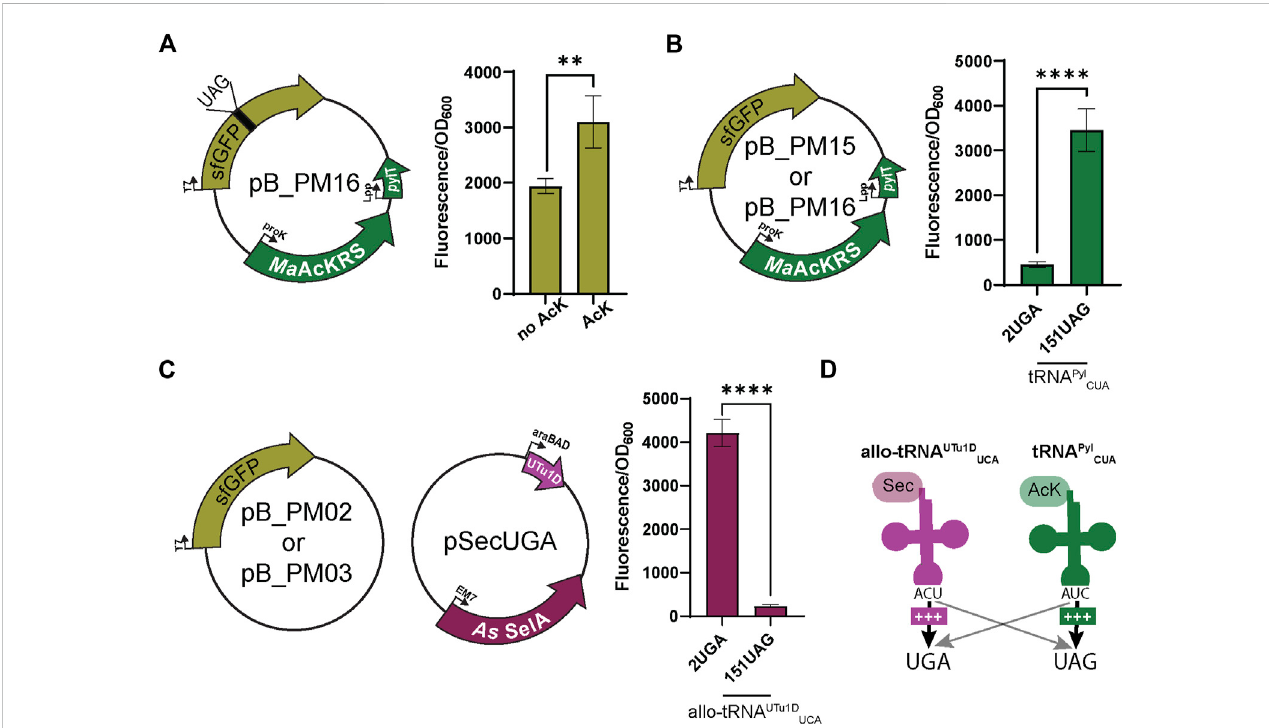
FIGURE 3 Anticodon swapcreatescodonorthogonality. (A) N ε -acetyl- L -lysine(AcK)wasstillfoundtoberequiredforsigni fi cant fl uorescence( p < 0.0001, n =4)of sfGFPwithplasmidpB_PM13.ThisplasmidcontainssfGFPunderthecontrolofaT7promoterencodingaUAGatposition151(151UAG), Ma AcKRS3-IPundera proK promoter, and tRNA Pyl CUA ( pylT ) under an Lpp promoter. (B) pB_PM12 and pB_PM13 encoding 2UGA or 151UAG, respectively, were tested for the speci fi city of tRNA Pyl CUA for its cognate codon (UAG). Signi fi cant increase in readthrough fl uorescence ( p < 0.0001, n = 4) was observed for 151UAG, the cognatecodon,comparedto2UGA. (C) CombiningplasmidspB_PM02orpB_PM03encoding2UGAor151UAG,respectively,andpSecUGAallowedatestfor UGA suppression by allo-tRNA UTu1D UCA . This plasmid contains the machinery for insertion of Sec, namely allo-tRNA UTu1D UCA (UTu1D) under the araBAD promoter and Aeromonas salmonicida ( As ) SelA under EM7. Signi fi cant increase in readthrough fl uorescence ( p < 0.0001, n = 4) was observed for 2UGA, the cognatecodon,comparedto151UAG. (D) Combiningthisinformation,allo-tRNA UTu1D UCA (magenta)isef fi cientatUGAsuppression,whiletRNA Pyl CUA (green)is ef fi cient atUAG suppression,creatingan orthogonal systemfor dualsuppression.Increaseinsuppressionef fi ciencyisdenotedbyanincreasein+and bolder arrow. Grey arrows denote that no suppression was